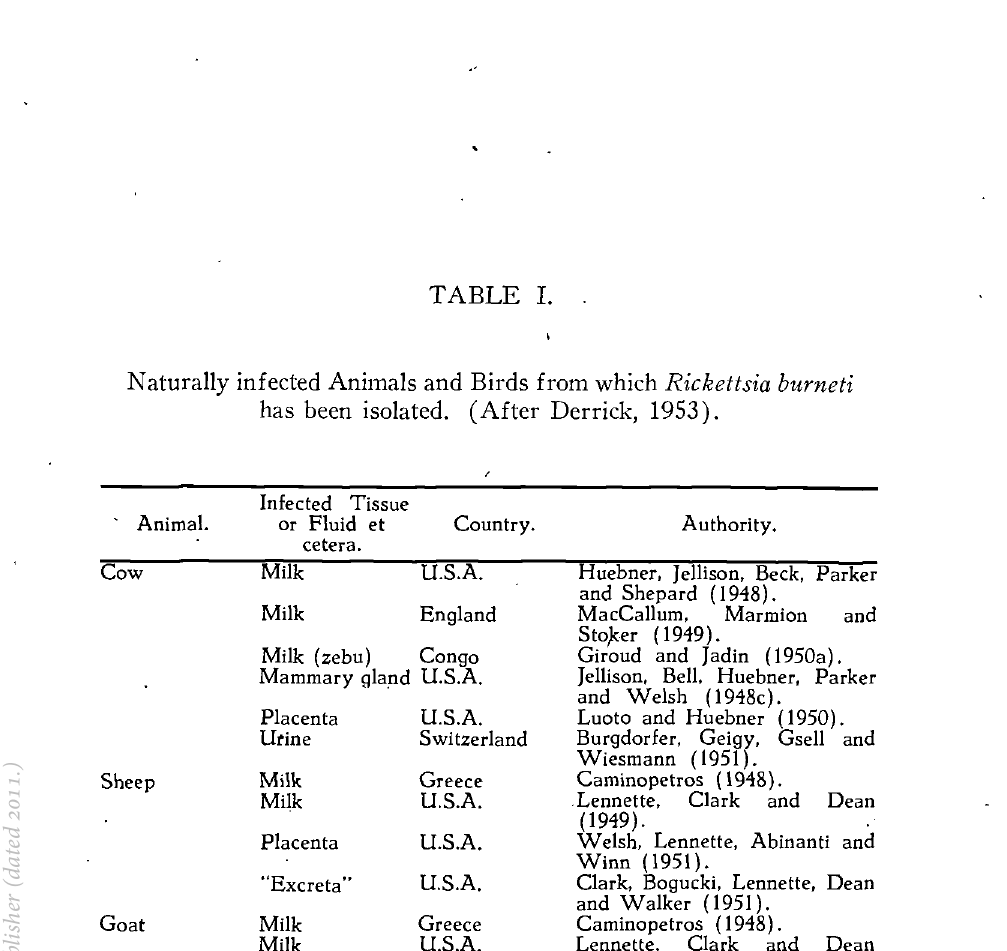
Naturally infected Animals and Birds from which Rickettsia burneti has been isolated. (After Derrick,